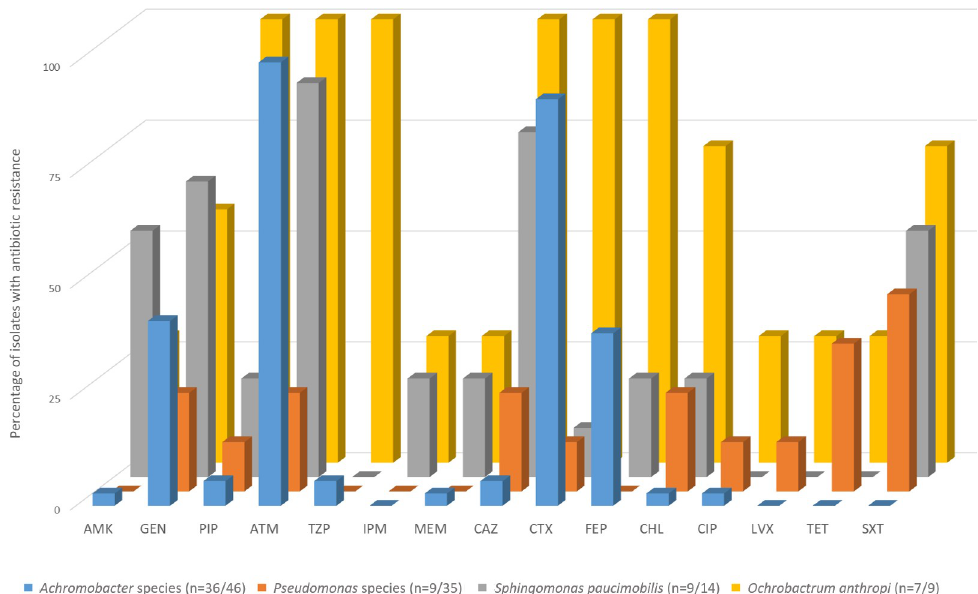
Fig 3. Antibiotic resistance levels by organism using the BD Phoenix identification system. Antibiotic abbreviation by drug class: Aminoglycosides: AMK–Amikacin, GEN—Gentamicin; Beta-lactam: PIP–Piperacillin, ATM–Aztreonam, TZP–Piperacillin-Tazobactam; Carbapenem: IPM–Imipenem, MEM–Meroenem; Cephalosporin: CAZ–Ceftazidime, CTX–Cefotaxime, FEP–Cefepime; CHL–Chloramphenicol; Fluoroquinolone: CIP–Ciprofloxacin, LVX–Levofloxacin; TET- Tetracycline; Folate Antagonist: SXT—Trimethoprim-Sulfamethoxazole. In the figure legend n = number of isolates for which BD Phoenix antimicrobial sensitivity test (AST) data was available/total number of species specific isolates in this study. For several isolates where AST data was not recorded the isolate grew too slowly to meet the growth control criteria cutoff. Clinical and Laboratory Standards Institute (CLSI) 2016 minimum inhibitory concentration break points were applied. Moraxella (n = 14) and Pasteurella (n = 12) species are not included in the BD Phoenix AST database and therefore this data is not available. https://doi.org/10.1371/journal.pntd.0007729.g003 Enhydrobacter . Taxonomer binned 46.6% of reads as bacterial (1,773,485) and a larger propor-